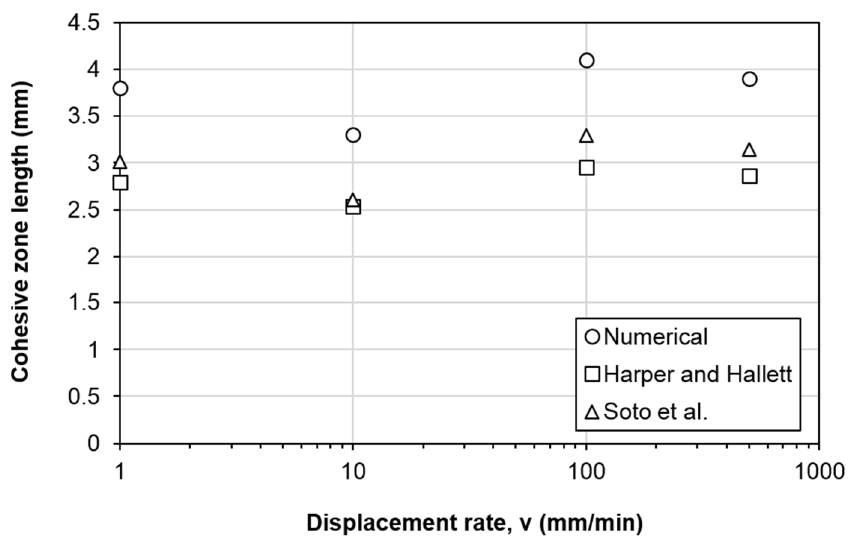
Figure 12. Crack growth profile at peak force for ( a ) 1 mm/min, ( b ) 10 mm/min, ( c ) 100 mm/min and ( d ) 500 mm/min cases.